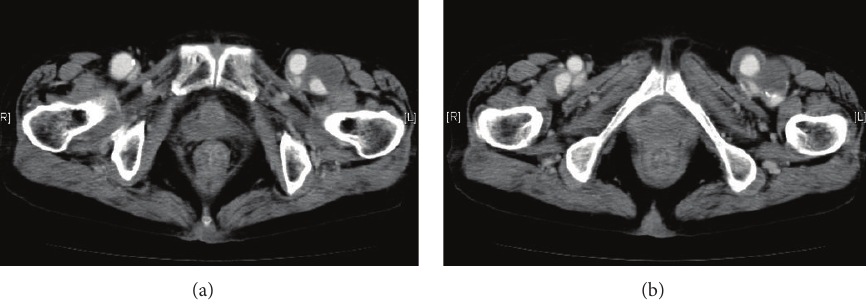
Figure 1: Computed tomography showed bilateral common femoral artery aneurysms (a) and bilateral profunda femoris artery aneurysms